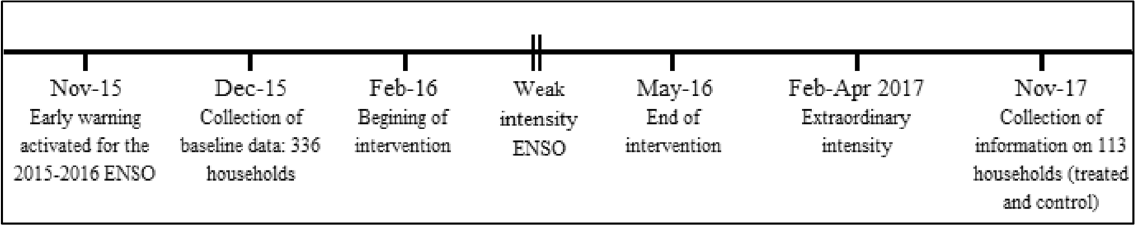
Fig. 6 Timeline of the El Nin˜o forecast-based intervention in Pisci District, Chiclayo Province, Peru´